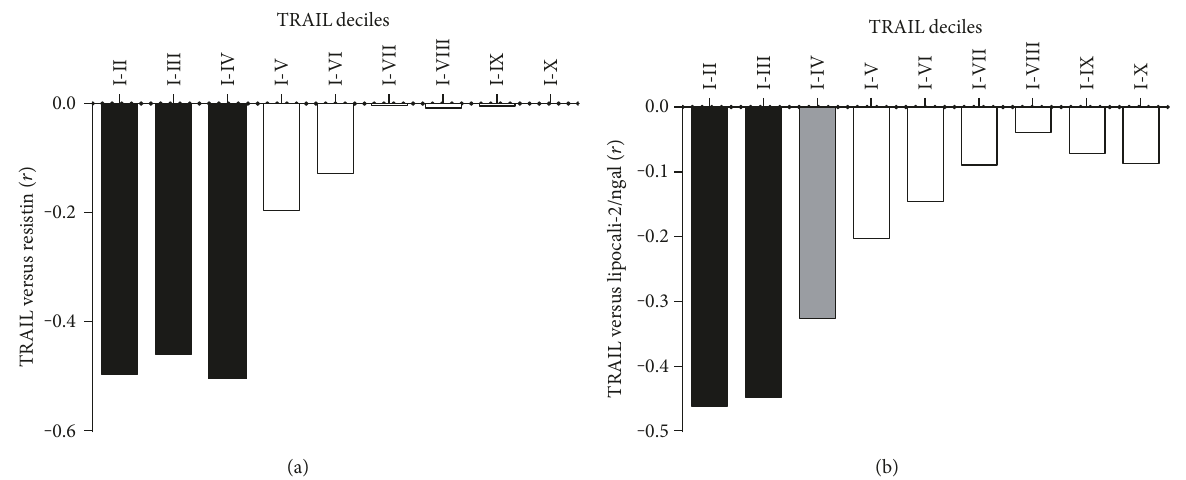
Figure 2: Pearson ’ s correlation coe ffi cient ( r ) values trend within cumulating TRAIL deciles. Box plot showing the correlation coe ffi cients for the relationship TRAIL versus resistin (a) and TRAIL versus lipocalin-2/ngal (b) calculated dividing subjects in deciles based on TRAIL concentration. Table 3: Ability of TRAIL to predict resistin or lipocalin-2/ngal changes within deciles I – IV evaluated by multiple regression analysis. Regression